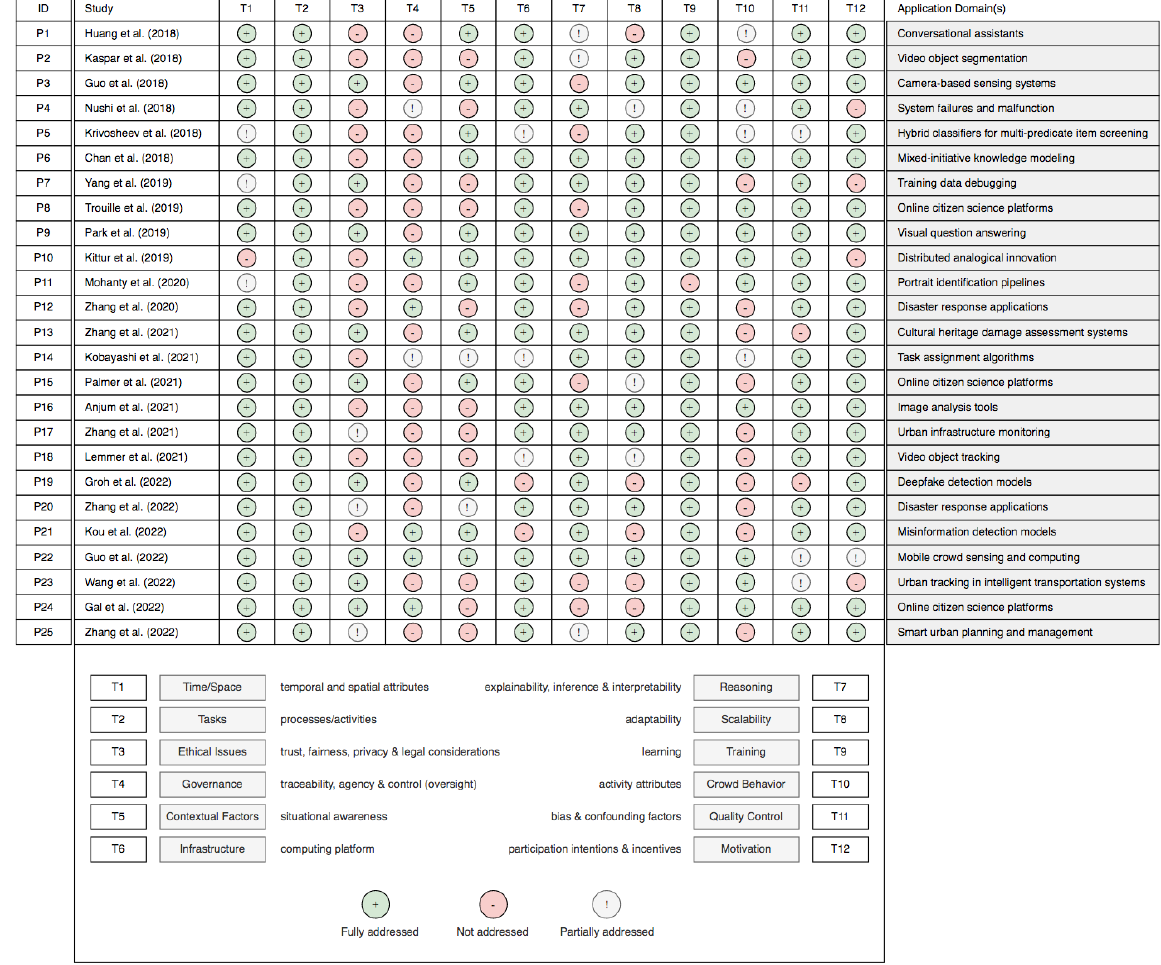
Figure 3. Synthesis of the literature analysis based on the taxonomy proposed.